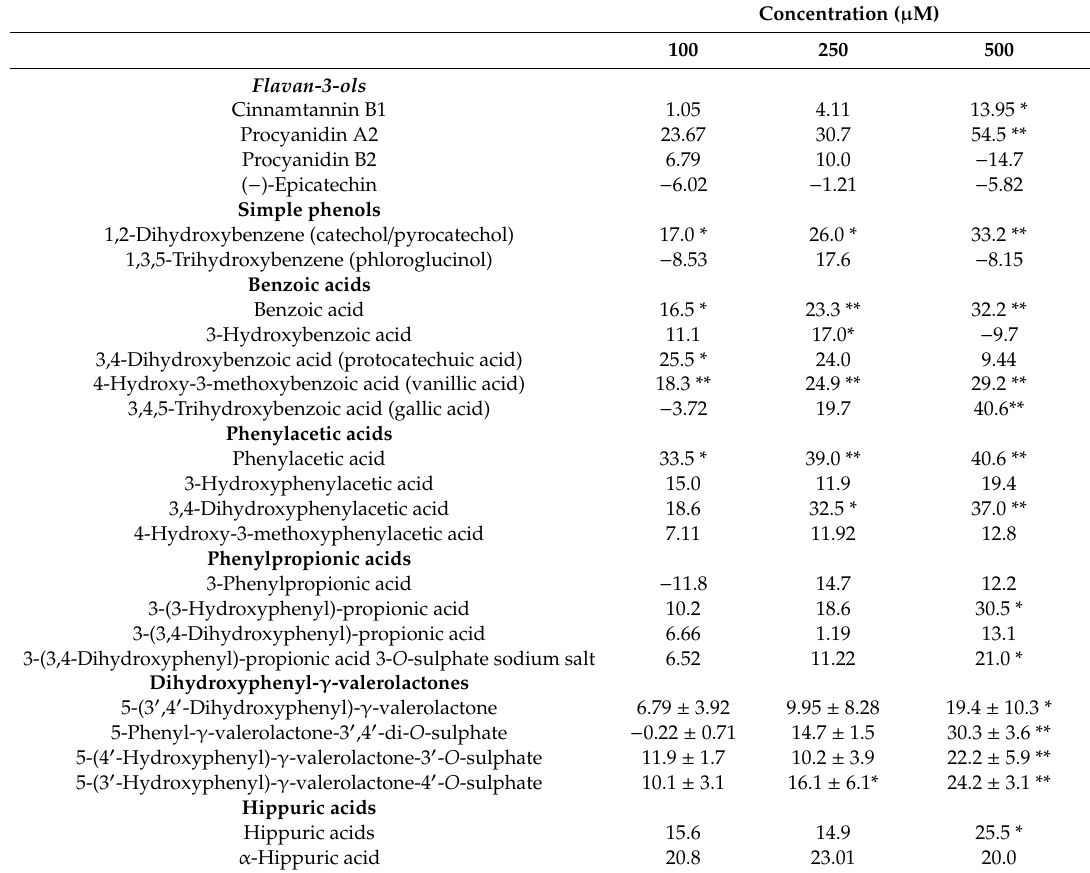
Table 1. Adherence Inhibition (%) of the of E. coli ATCC ® 53503 ™ to ATCC ® HTB4 ™ cells by phenolic compounds (Adapted from Gonz á lez de Llano et al.